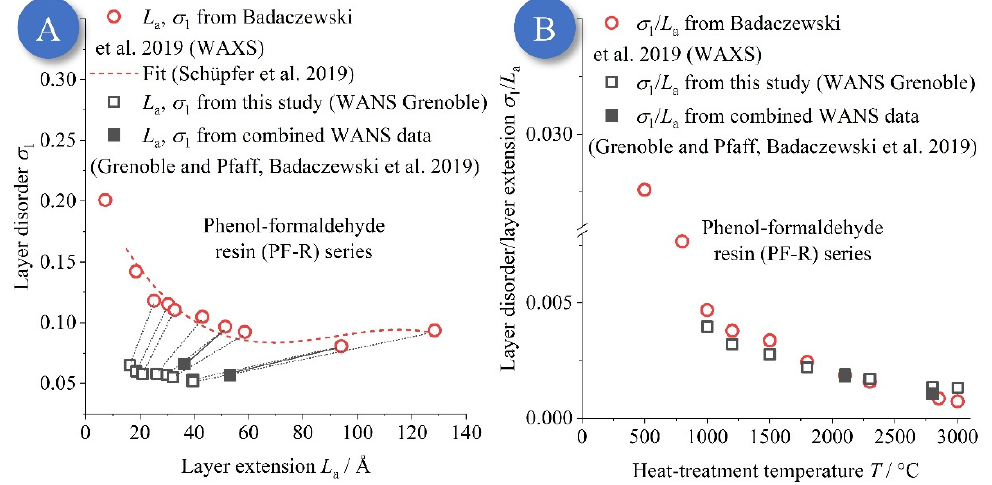
Figure 9. ( A ): Plot of σ 1 vs. L a for the phenol-formaldehyde resin (PF-R) temperature series. determined by WANS and previous WAXS results from Pfaff et al. 2019 [43] and fitted by Schüpfer et al. 2019 [25]. This comparison illustrates that the σ 1 values were much smaller than previously assumed. ( B ): However, the ratio σ 1 / L a did not change, compared to our previous studies, over the whole temperature range. This agreement is due to the fact that it is these two parameters which determine the profile of the ( hk ) reflections, i.e., their widths, especially at large s values. A similar figure for the pitches can be found in the SI file as Figure S15.